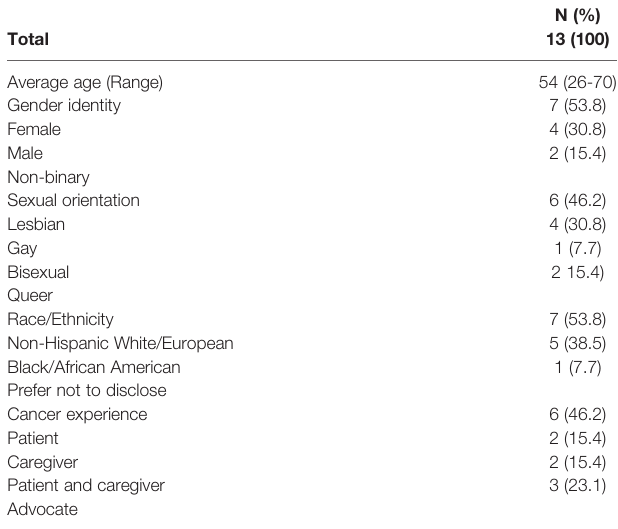
TABLE 1 | Demographic characteristics of the LGBT cancer action council members (2017 –